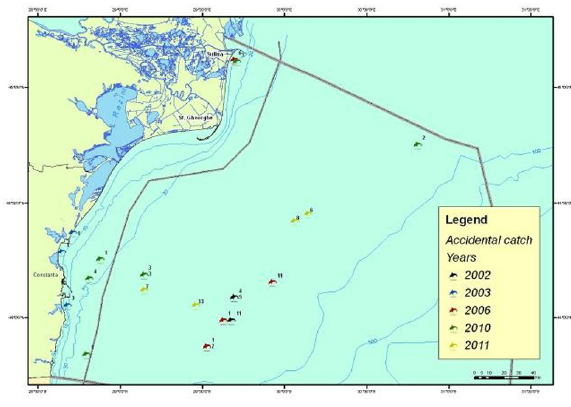
Fig. 4. – Distribution of accidental catches in 2002-2011.